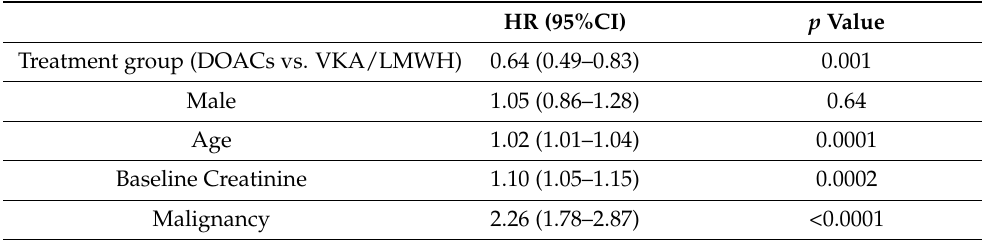
HR (95%CI) p Value